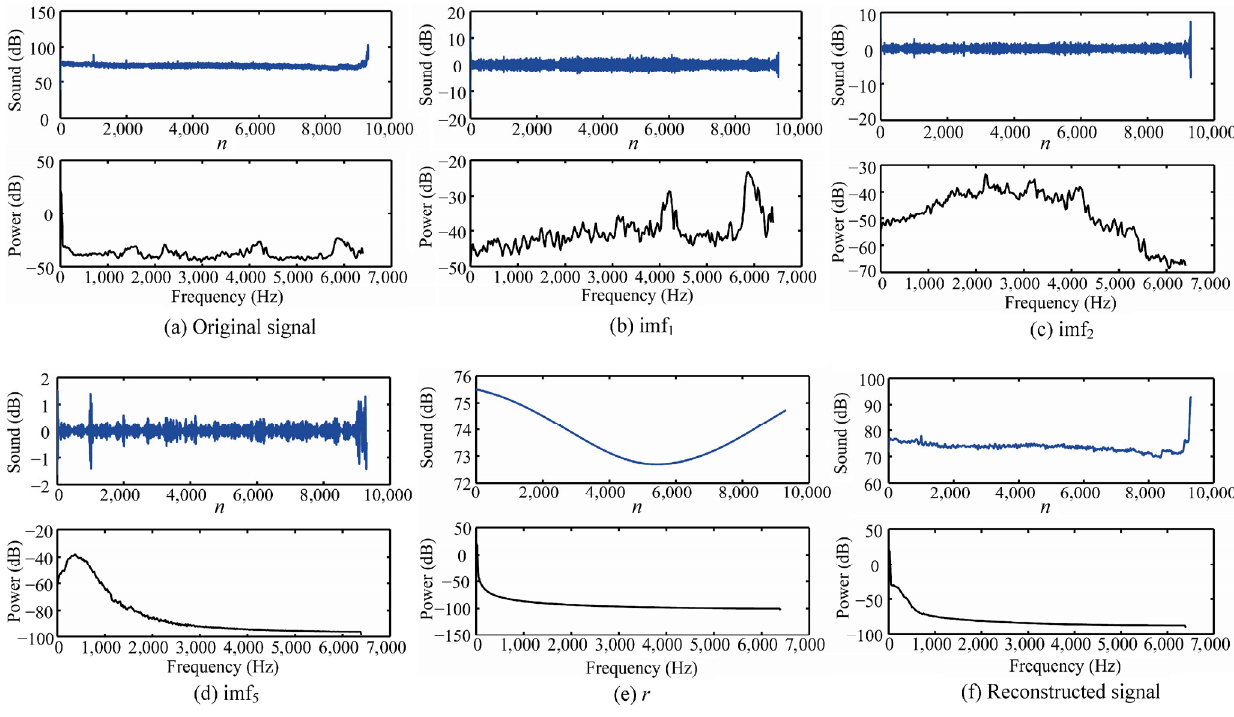
Fig. 4 imf components in time-domain and frequency-domain.